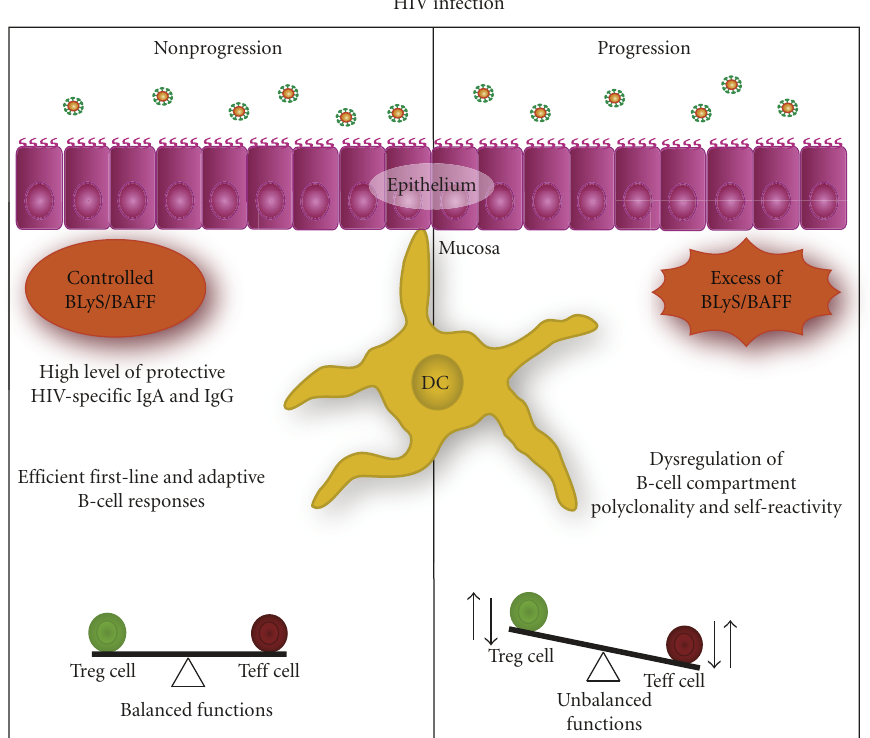
Figure 1: The implication of BLyS/BAFF expression status in the modulation of HIV-specific reponses. Control of HIV infection is reflected by the capacity to regulate BLyS/BAFF expression status at mucosal sites, where the main battle against HIV takes place, promoting e ffi cient HIV-specific B- and T-cell responses, viewed to block systemic invasion by the virus. In contrast, breaching of systemic integrity and progression of HIV infection is reflected by the incapacity to control BLyS/BAFF levels at mucosal sites, leading to dysregulated B- and T-cell responses, impairing the generation of highly protective HIV-specific